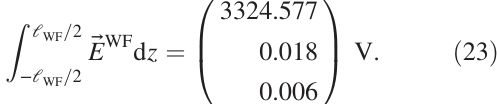
oscillation amplitude is equal to the tilt angle ξ y